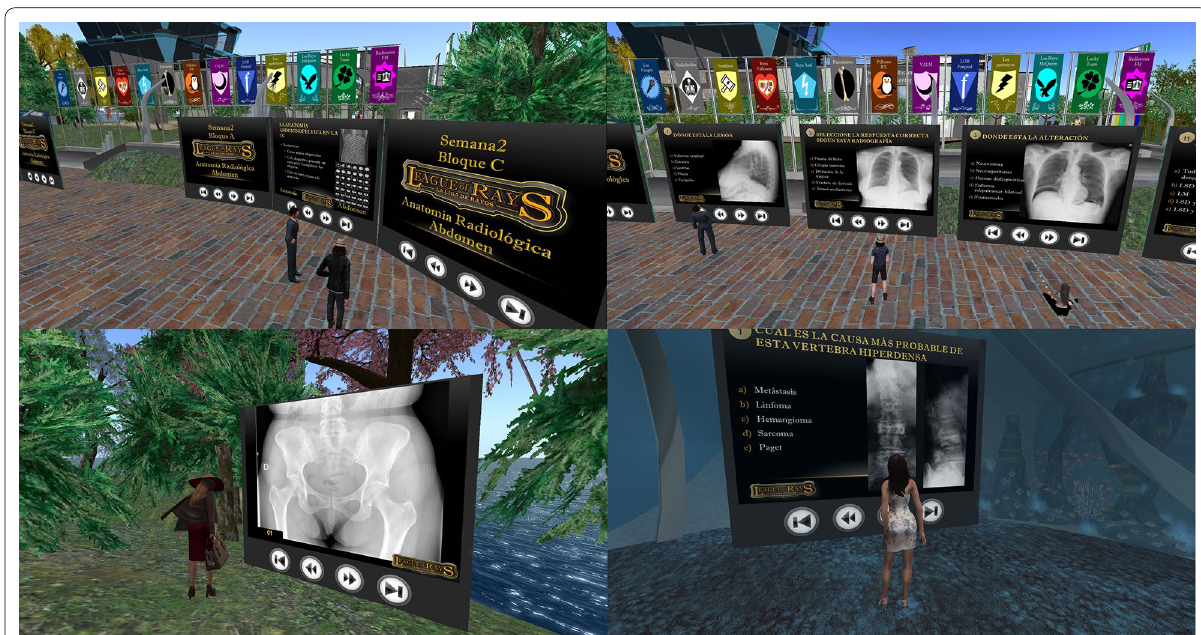
Fig. 2 Different scenes during the League of Rays game. Top left: students viewing a set of three learning panels on radiographic anatomy of the abdomen. Top right: Students in front of panels with weekly tests on the central esplanade. Bottom left: a student in front of an N/P task located between the trees. Bottom right: student conducting a weekly test at an underwater facility